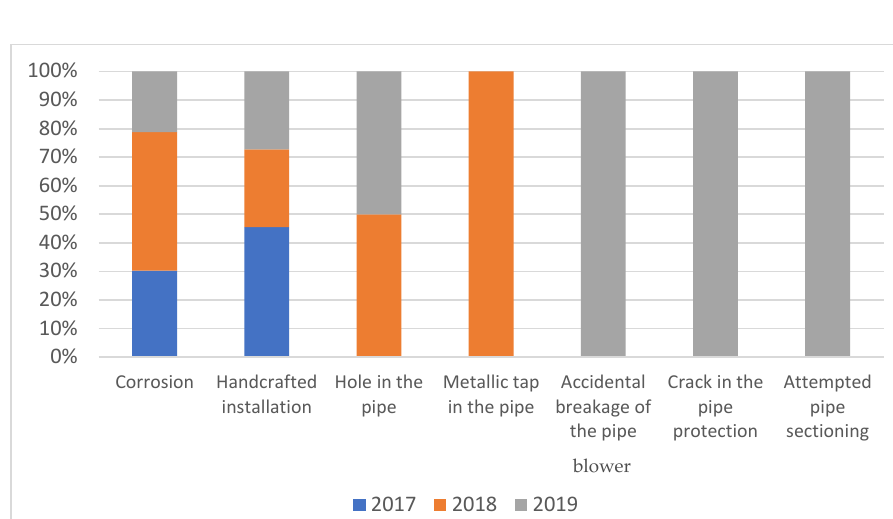
23.4% of the total Table 7. Hierarchy of incident causes for 2017–2019.